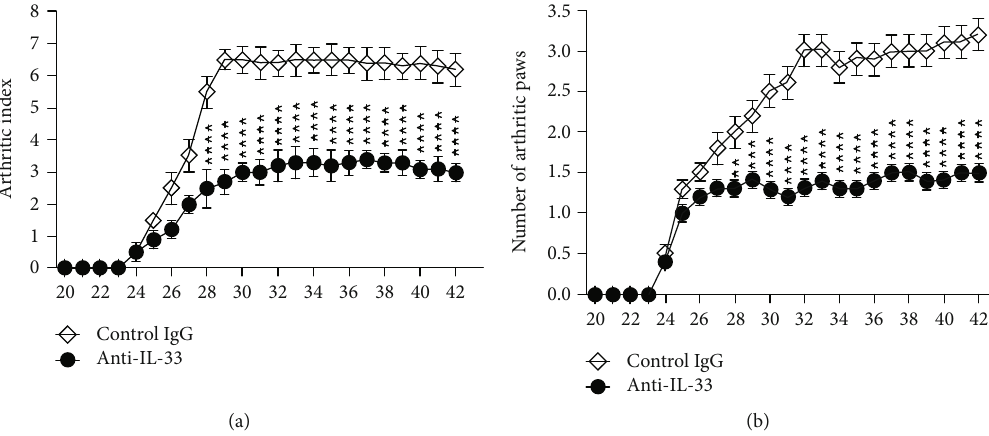
Figure 2: Anti-IL-33 inhibited the development of CIA in mice. From days 25 to 27, CIA mice were injected i.p. with anti-IL-33 or normal rabbit IgG (both 150 μ g/dose, n = 10 ) and then injected once every 3 days until day 42 for a total of 8 doses. According to arthritic index (a) and number of arthritic paws (b), the disease progression of mice was analyzed. Compared with the control IgG, anti-IL-33 treatment can signi fi cantly reduce the symptoms of arthritis in mice. Data are mean ± SEM ( n = 10 ); ∗∗ p < 0 : 01 , ∗∗∗ p < 0 : 001 , and ∗∗∗∗ p < 0 : 0001 vs. the control IgG group by two-way ANOVA with Bonferroni ’ s multiple comparison